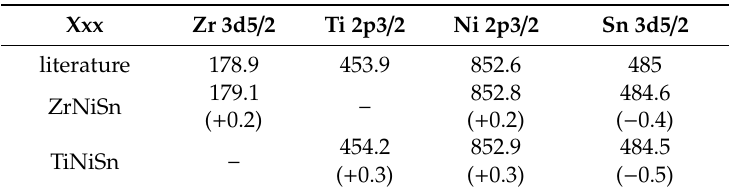
Figure 3. Survey spectrum taken from the ZrNiSn alloy surface after sputter-cleaning. Table 1. Binding energy (eV) of the elements in the alloys and the known literature values [12–14,16]. The chemical shifts are shown in brackets.